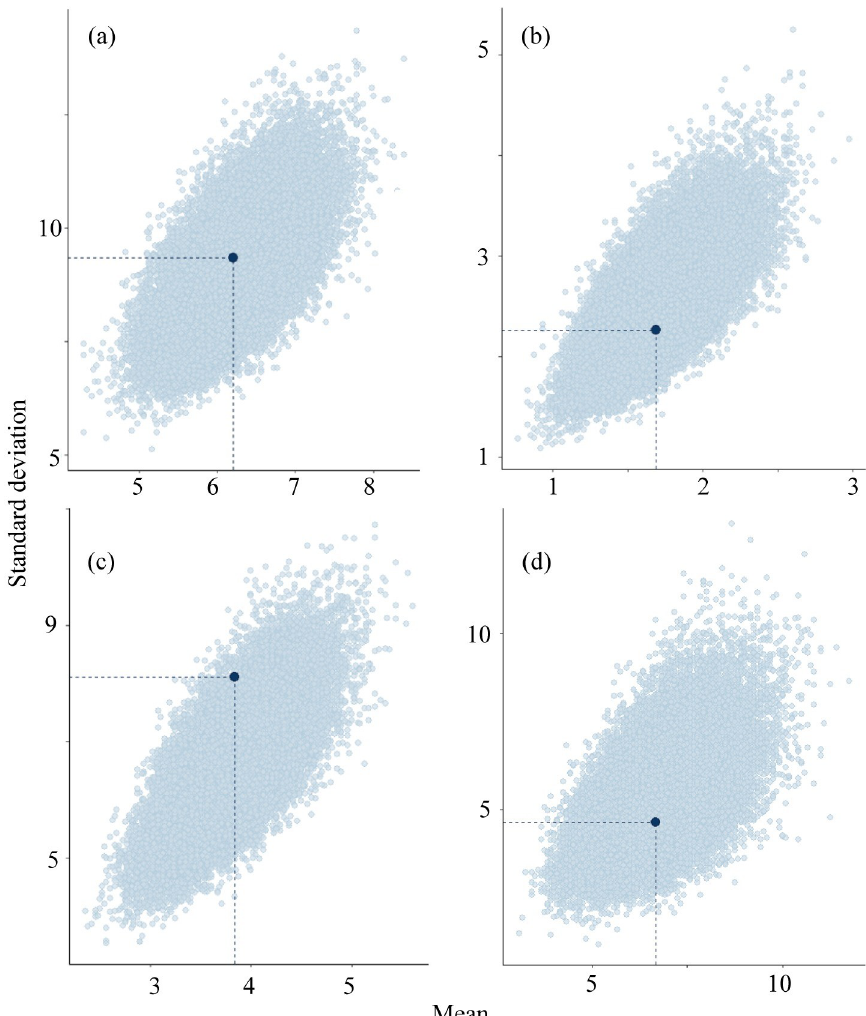
Fig 4. Mean and standard deviation of value of the test statistic computed from the observed values (dark blue dot) and those from the estimated values for 1000 simulated data sets drawn from the posterior predictive distribution (light blue dots). (a) C a , (b) C b , (c) C e , (d)